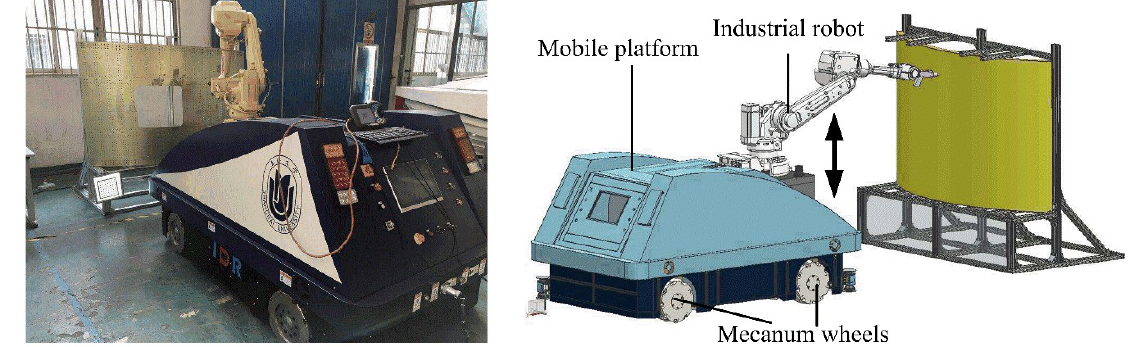
Figure 1. Mobile robotic assembly system.